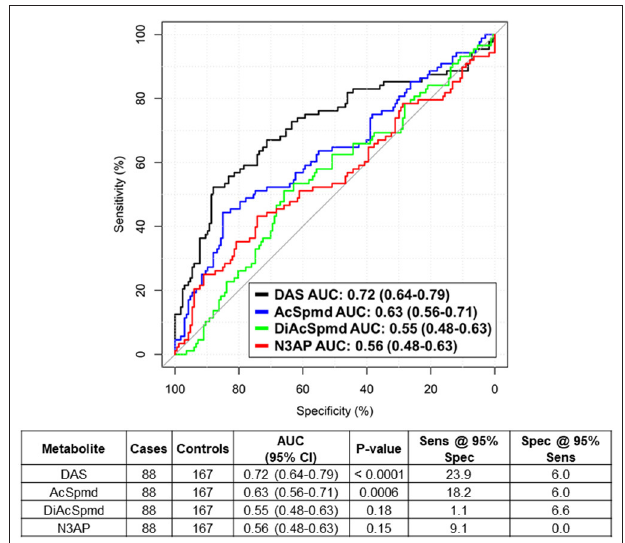
FIGURE 1 | Predictive performance of individual polyamines for distinguishing treatment-naïve TNBC cases from healthy controls. Table beneath shows AUC (95% CI), Wilcoxon rank sum test 2-sided P -values as well as sensitivity and specificity estimates at 95% specificity/sensitivity thresholds of individual polyamines for distinguishing TNBC cases from healthy